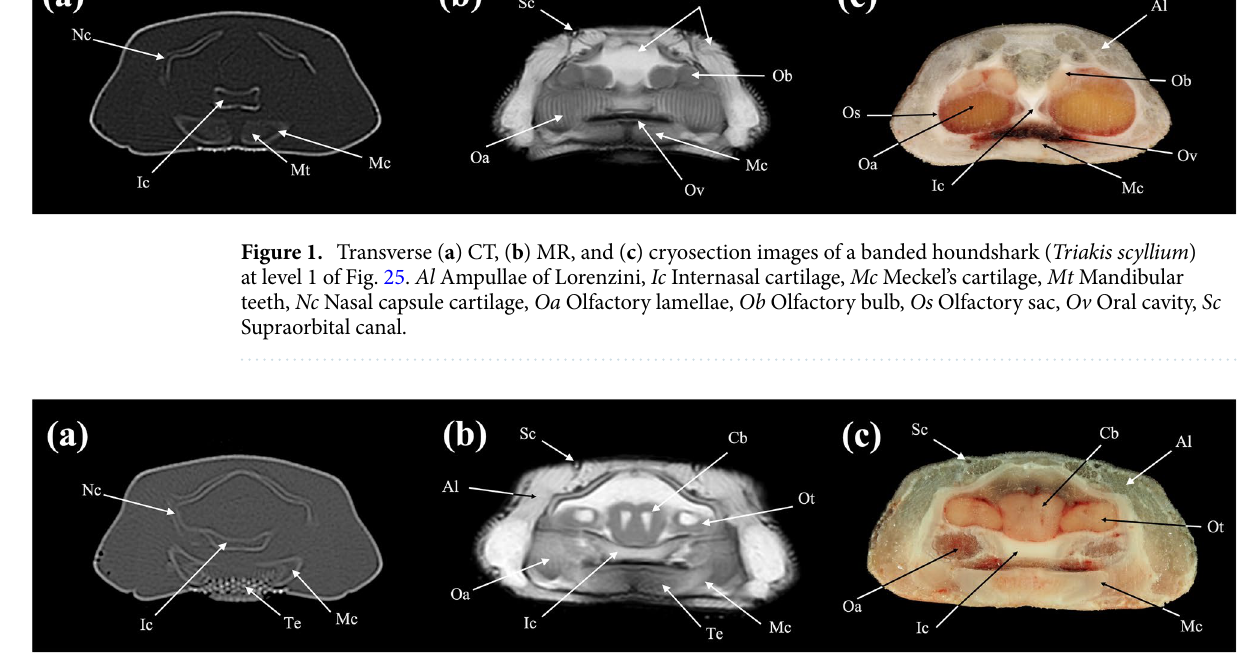
Figure 2. Transverse ( a ) CT, ( b ) MR, and ( c ) cryosection images of a banded houndshark ( Triakis scyllium ) at level 2 of Fig. 25. Al Ampullae of Lorenzini, Cb Cerebrum, Ic Internasal cartilage, Mc Meckel’s cartilage, Te Teeth, Nc Nasal capsule cartilage, Oa Olfactory lamellae, Ot Olfactory tract, Sc Supraorbital canal.